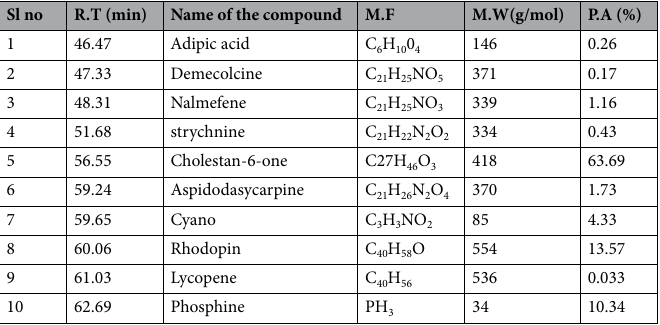
Table 5. Phytochemical components of Indigofera tinctoria ethyl acetate fraction by GC–MS.